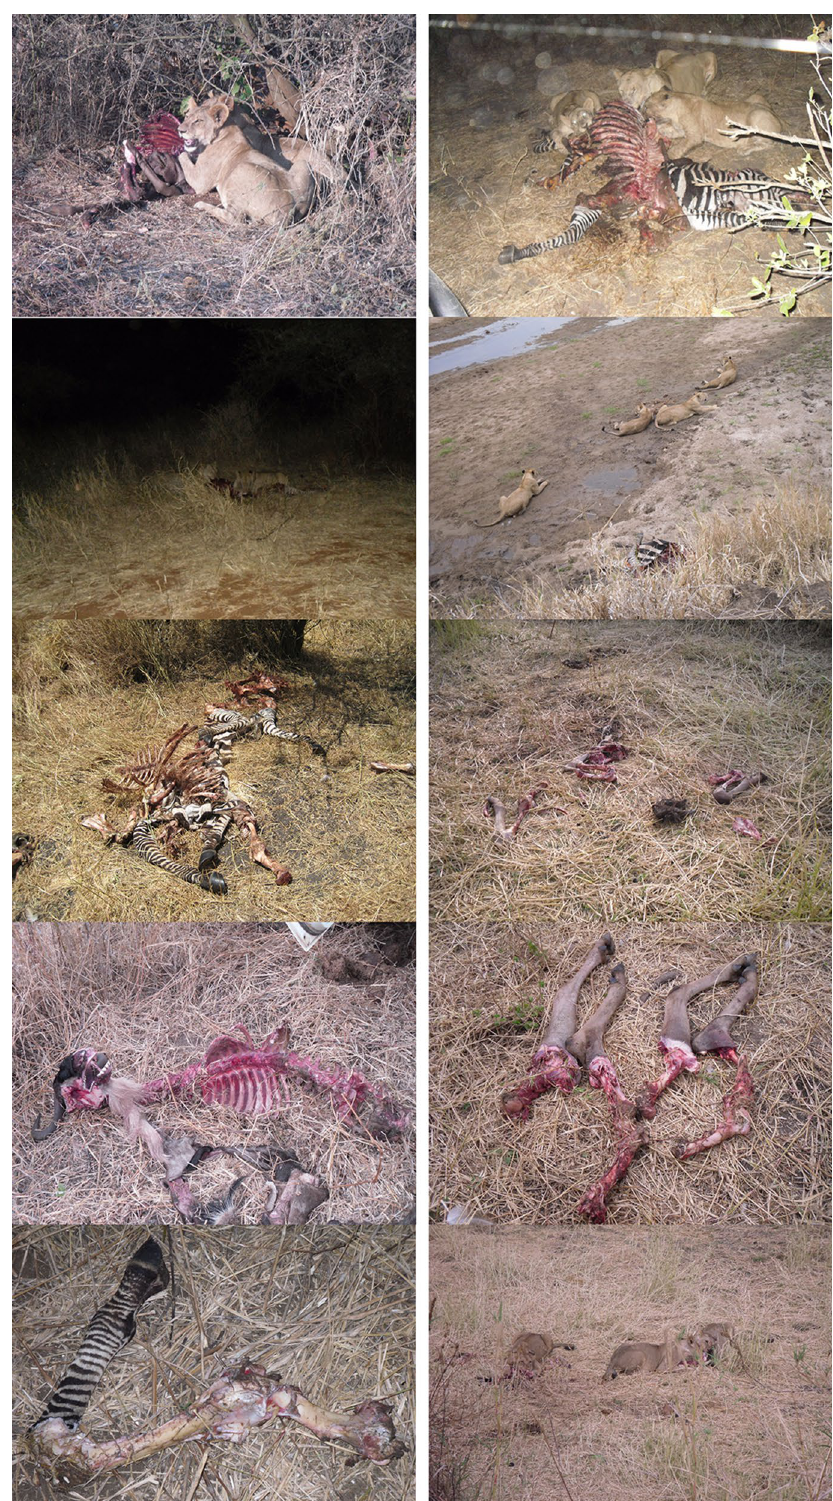
Figure 1. Examples of carcass consumption by lions at Tarangire. Carcasses are arranged by order according to Table